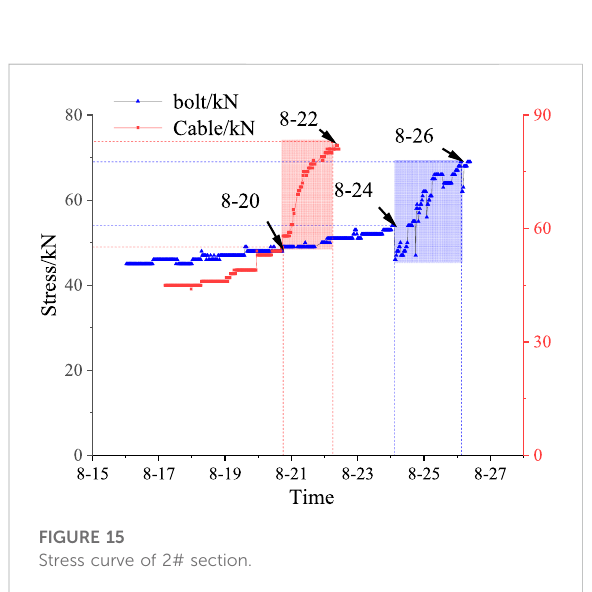
FIGURE 15 Stress curve of 2# section.